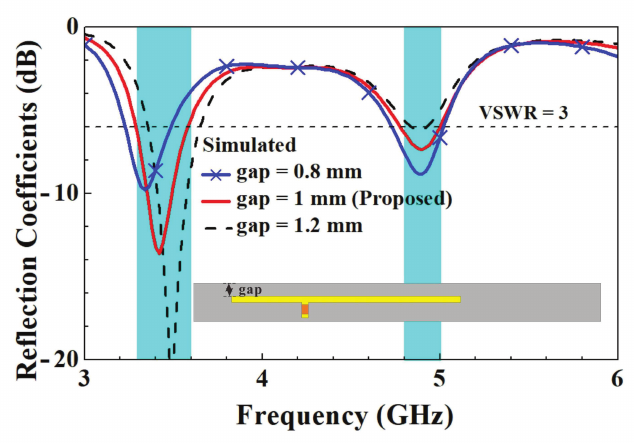
Figure 17. Comparison of simulated reflection coefficients with changes in parameter gap.